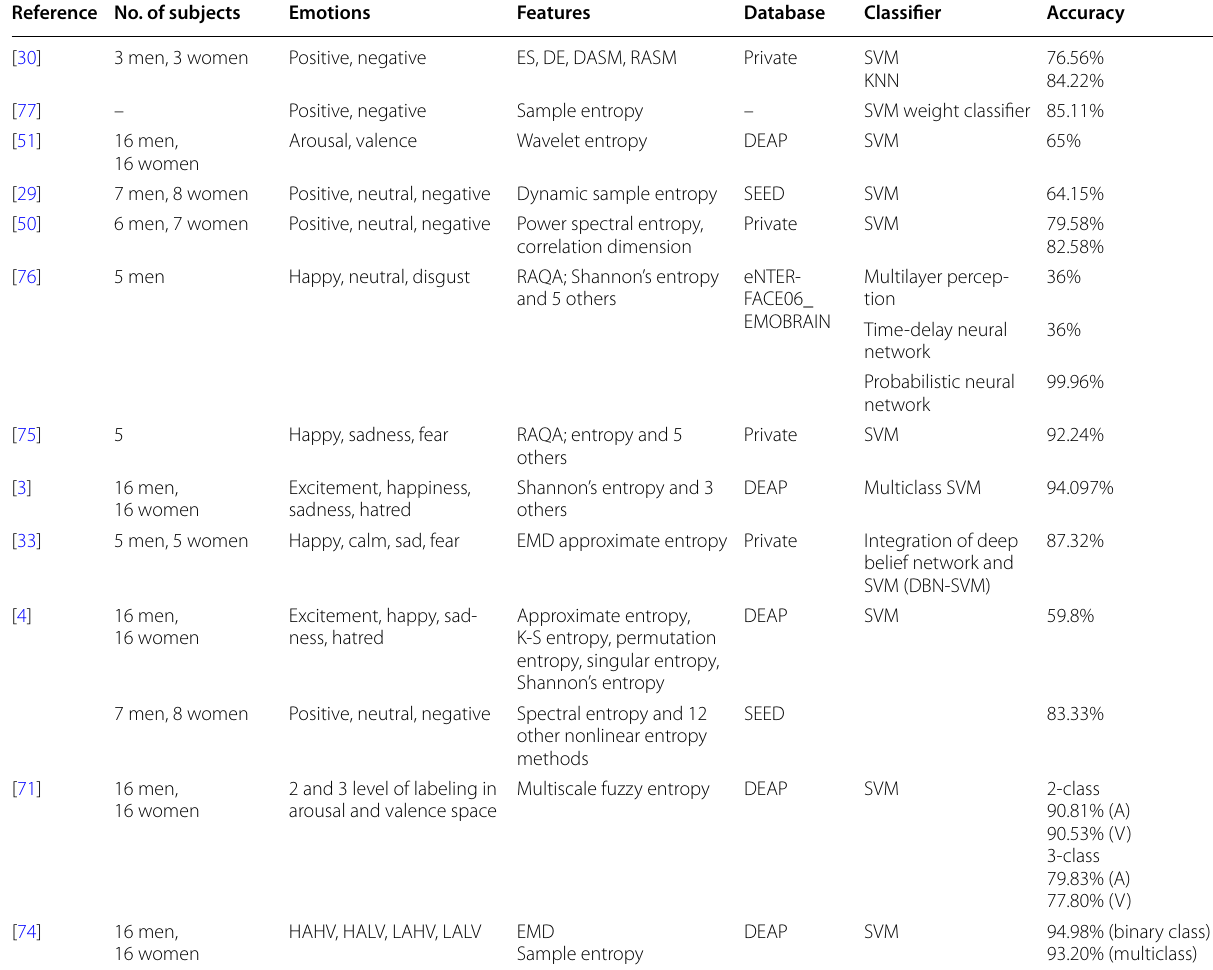
Table 1 Summary of studies conducted on EEG-based emotion recognition using entropy as a feature Reference No. of